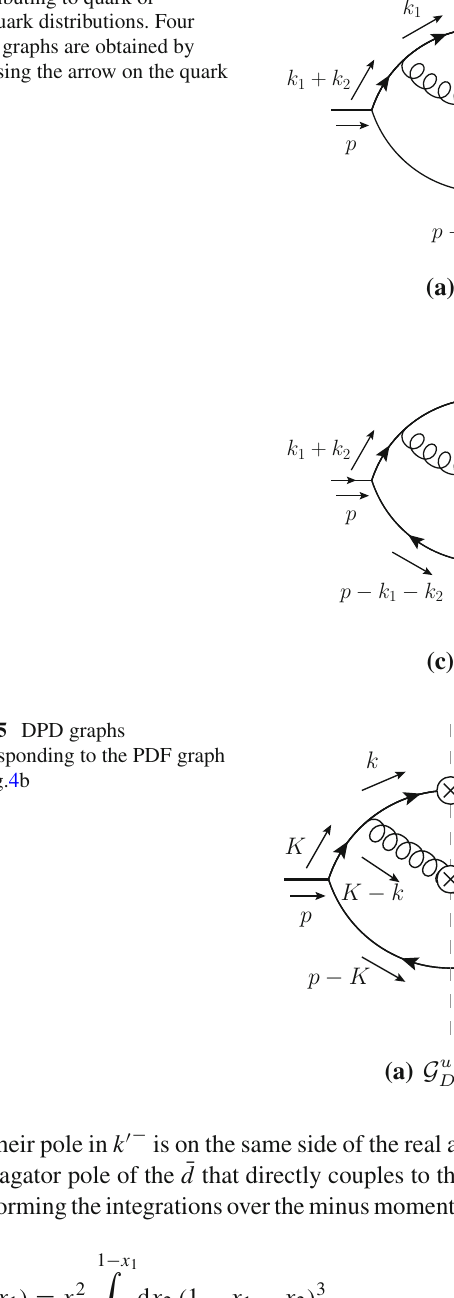
Fig. 4 Real emission graphs contributing to quark or antiquark distributions. Four